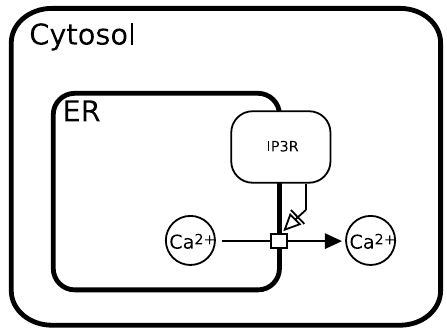
Figure 2.51: The transport of calcium ions out of the endoplasmic reticulum into the